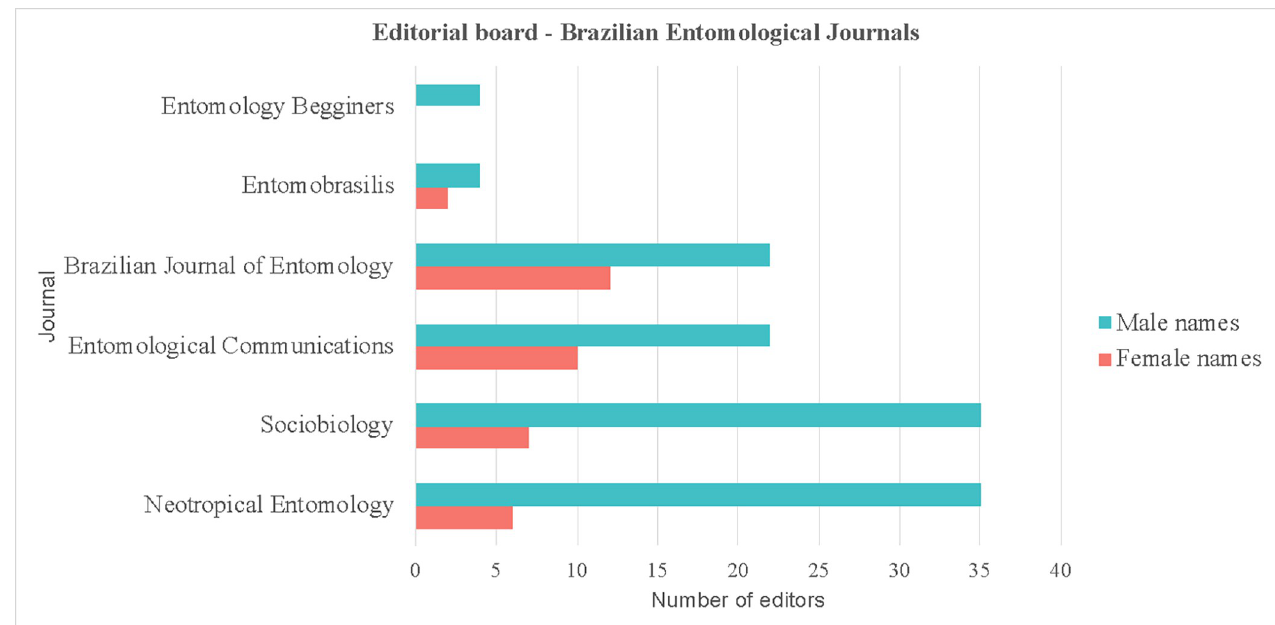
Fig 4. Total number of researchers in the editorial board of the Brazilian journals dedicated to Entomology.